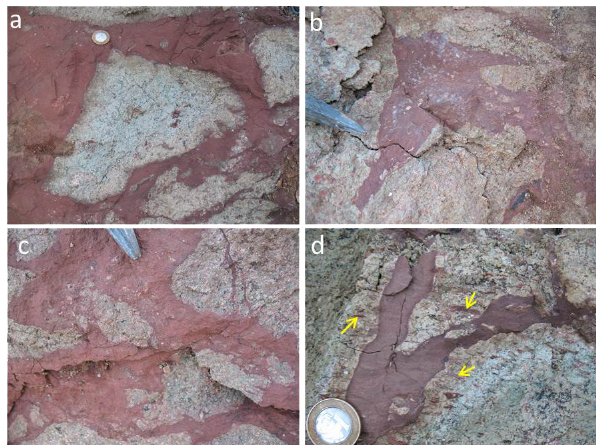
Fig. 9. Aspects of a peperite produced by interaction of a thin basalt flow (within the silicic Palmas Member) and fine-grained sediment near Nova Petrópolis (Rio Grande do Sul State), southern part of the basin: (a–c) irregular blocky volcanic clasts (V) in a reddish sandstone matrix (S), and (d) photomicrograph showing the amyg- daloidal basalt (V) in the upper part and a poorly sorted fine-grained sandstone in the bottom (S).